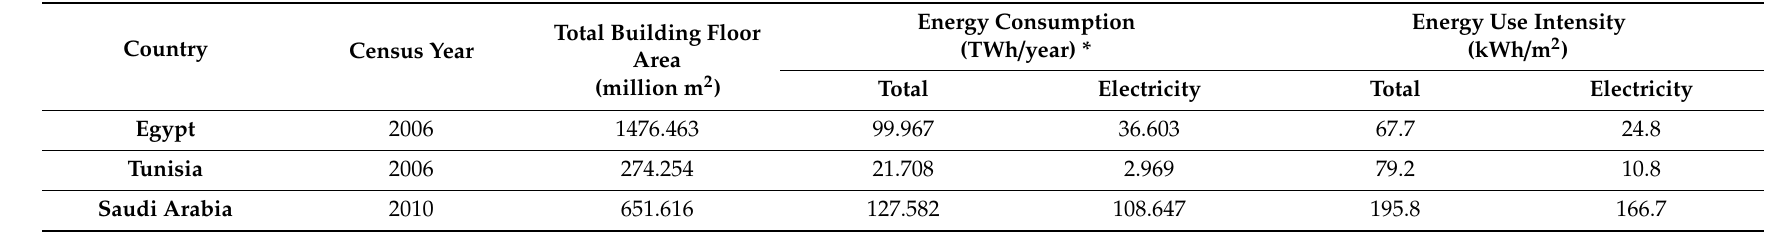
Table 10. Estimation of EUI for residential buildings based on data reported for three Arab countries.